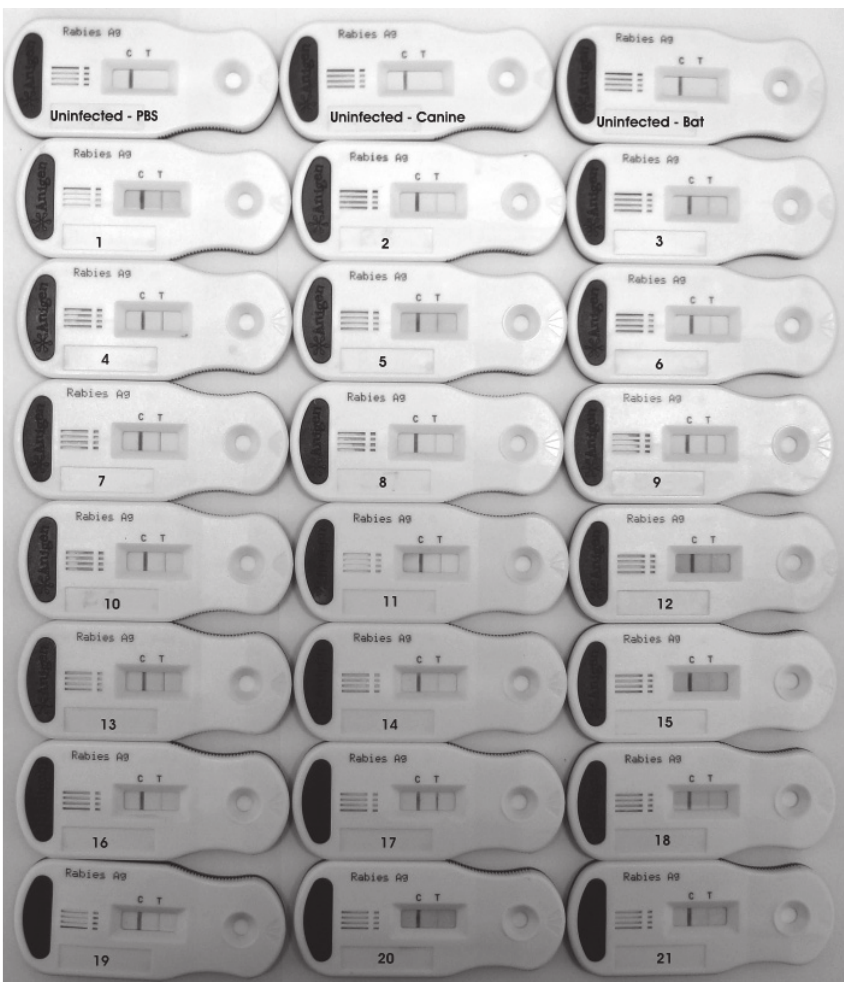
Results of the Rapid immunodi- agnostic test (RIDT) after testing negative control samples as well as representatives of Afri- can lyssaviruses (Table 1). Sam- ples 1–21 indicate a positive re- sult with different representatives of African lyssaviruses. Negative control samples (PBS, canine and bat uninfected brain) indi- cated a neg ative result. C = con- trol line and T= test